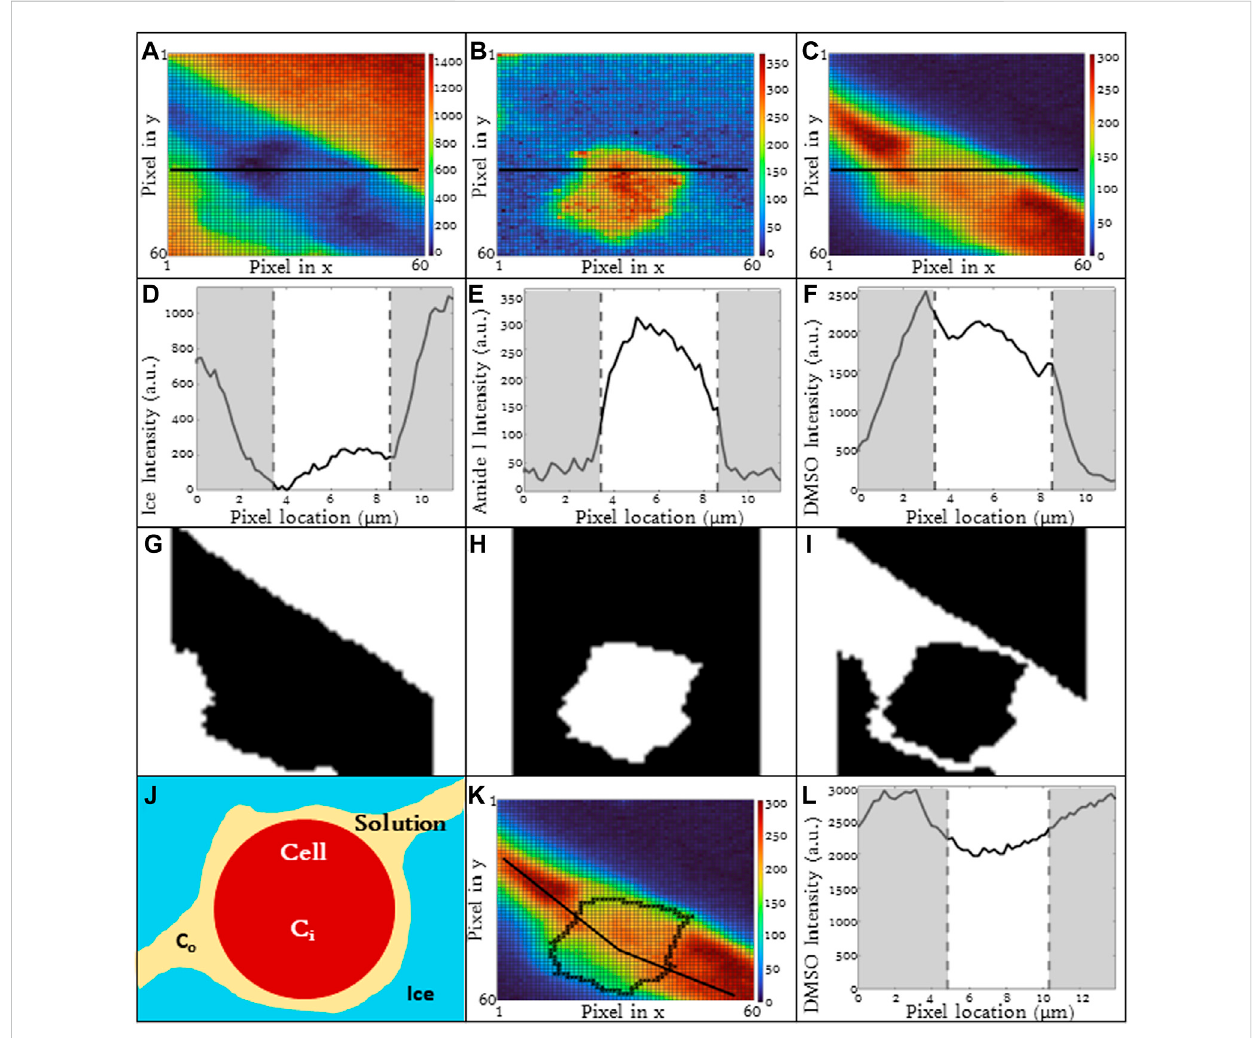
FIGURE 1 Raman heat maps of T-cell in 10% DMSO frozen using a -1 ° C/min cooling rate and imaged at a temperature of − 50 ° C. Heat maps show intensity of (A) ice, (B) cell (amide I), and (C) DMSO. Intensity was de fi ned as the area under the speci fi ed peak. This peak width was de fi ned with derivative thresholding, and all background below the spectral trend was subtracted. Line plots across the center of each show variation of spectral peak intensity acrosstheimagefor (D) ice, (E) cell,and (F) DMSO.Binarycellimagefromedgedetectionandcellmorphologytodeduceregionsofinterestinwhite. From left to right, white signi fi es (G) ice, (H) cell, and (I) unfrozen channel. (J) The partitioning ratio of CPA is de fi ned as the ratio of the extracellular concentration divided by theintracellularconcentration, aline plotacrossthe cell demonstrates thevariation inDMSO concentration across thecell and intheextracellularsolution (K,L) .Pixelsin (A – C) haveaheightandwidthof200 nm. (D , E , F,L) regionsofgrayareinextracellular/iceregionsandregionsof white is